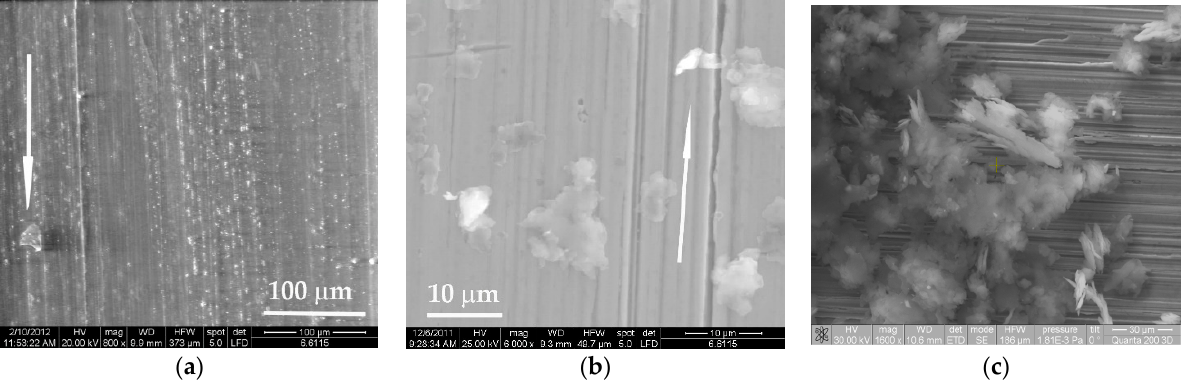
Figure 15. Worn surface of the PBT block, tested under 5 N, L = 7500: ( a ) abrasive wear and a wear particle reattached to the friction surface, v = 0.75 m/s; ( b ) v = 0.25 m/s abrasive wear located next to the friction path of the steel ring; ( c ) wear debris expelled from the contact near the friction path on the ring the block made of PF10.